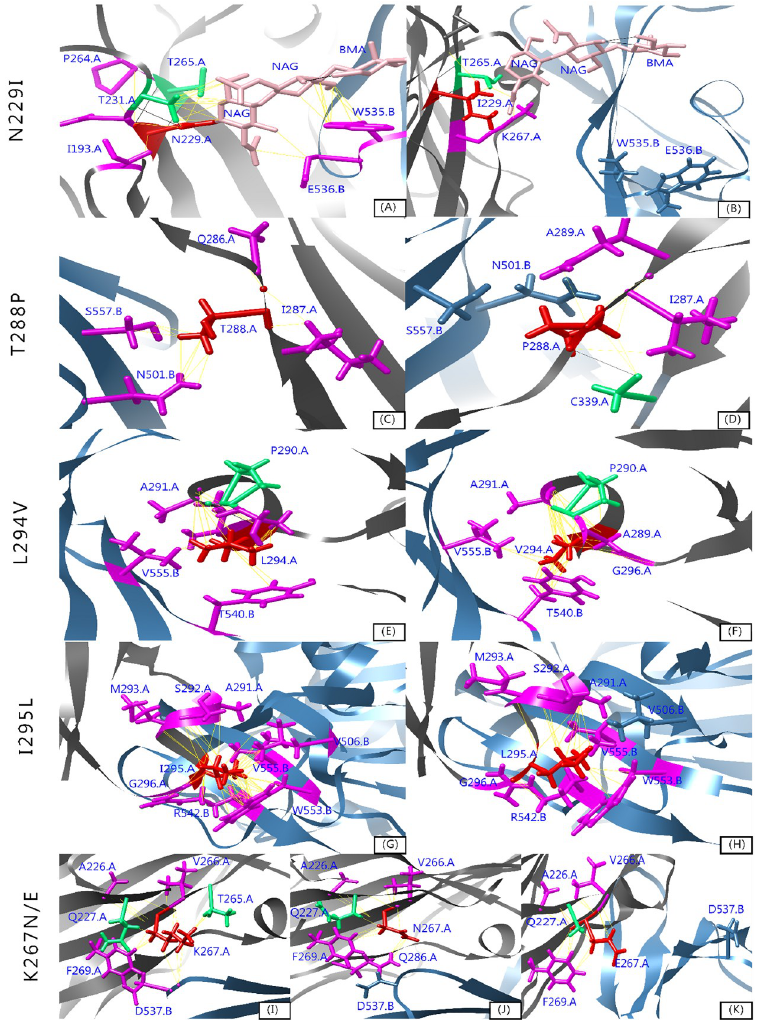
Fig 9. Structural model of wild and mutant 4L72 models after 150 ns MD simulation. Residues substituted are marked in red, residues involved in hydrophobic interactions are indicated in magenta, residues engaging simultaneous hydrogen bonding and hydrophobic contacts are indicated in green. DPP4 (chain A) and MERS-CoV S1 RBD protein (chain B) are dyed respectively with grey and blue. Ligands (NAG, BMA) are highlighted in pink. Hydrogen bonds are shown in black line and hydrophobic/ionic contacts are shown in yellow